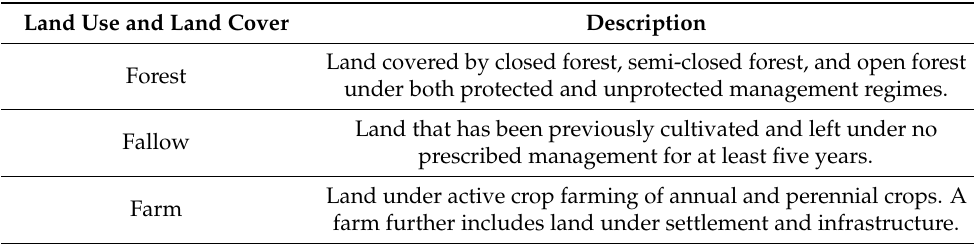
Table 1. Land use classes for the assessment of land use, land cover, and forest fragmentation. Land Use and Land Cover Description Land covered by closed forest, semi-closed forest, and open forest Forest under both protected and unprotected management regimes. Land that has been previously cultivated and left under no Fallow prescribed management for at least five years. Land under active crop farming of annual and perennial crops. A Farm farm further includes land under settlement and